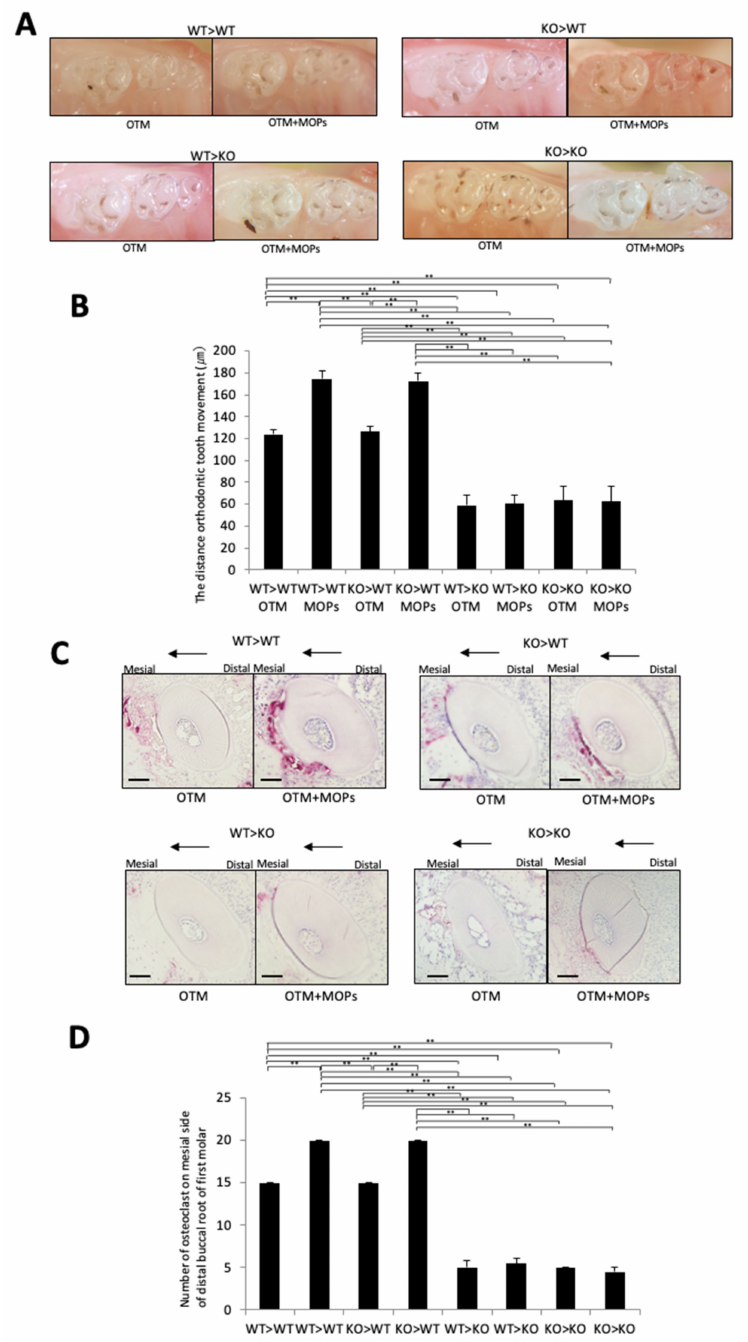
Figure 5. Tooth movement in chimeric WT and KO mice with or without MOPs after 12 days of OTM: ( A ) Images of tooth movements after 12 days of orthodontic force loading in chimeric WT and KO mice with and without MOPs. ( B ) Measured tooth movement distance in chimeric WT and KO mice with and without MOPs after 12 days of experimental loading. ( C ) TRAP-stained histological sections of the distobuccal root of the maxillary left first molar in chimeric WT and KO mice after 12 days of experimental loading. ( D ) The TRAP-positive osteoclast cell number along the alveolar bone surface around the distobuccal root of the left maxillary first molar after 12 days of OTM for chimeric WT and KO mice with and without MOPs. The results are given as the mean ± standard deviation ( n = 4). ** p < 0.01 indicate significant differences, which were analyzed by using the Scheffe test. Scale bars = 100 µ